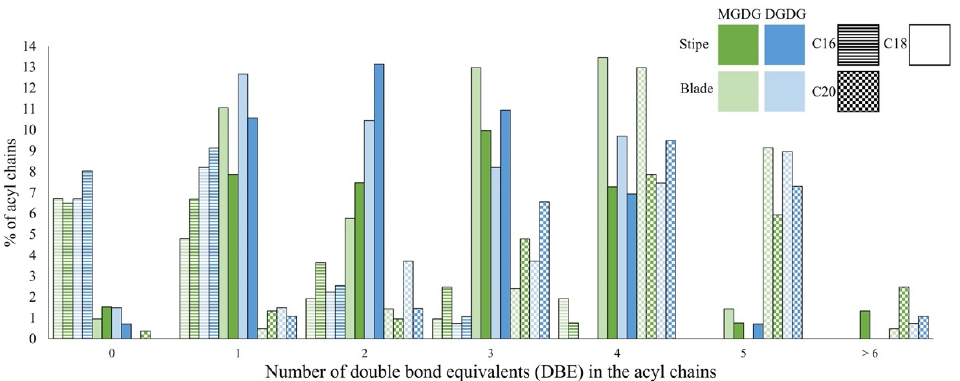
Figure 4. Distribution of the double bond equivalents (DBE) of the C16 (striped), C18 (no pattern) and C20 (chequered) acyl chain for mono- and digalactosyldiacylglycerols (MGDG and DGDG, respectively) of blade and stipe from Laminaria hyperborea . Note that this figure represents the number of identified acyl chains with a given DBE, not the quantity of the lipids.